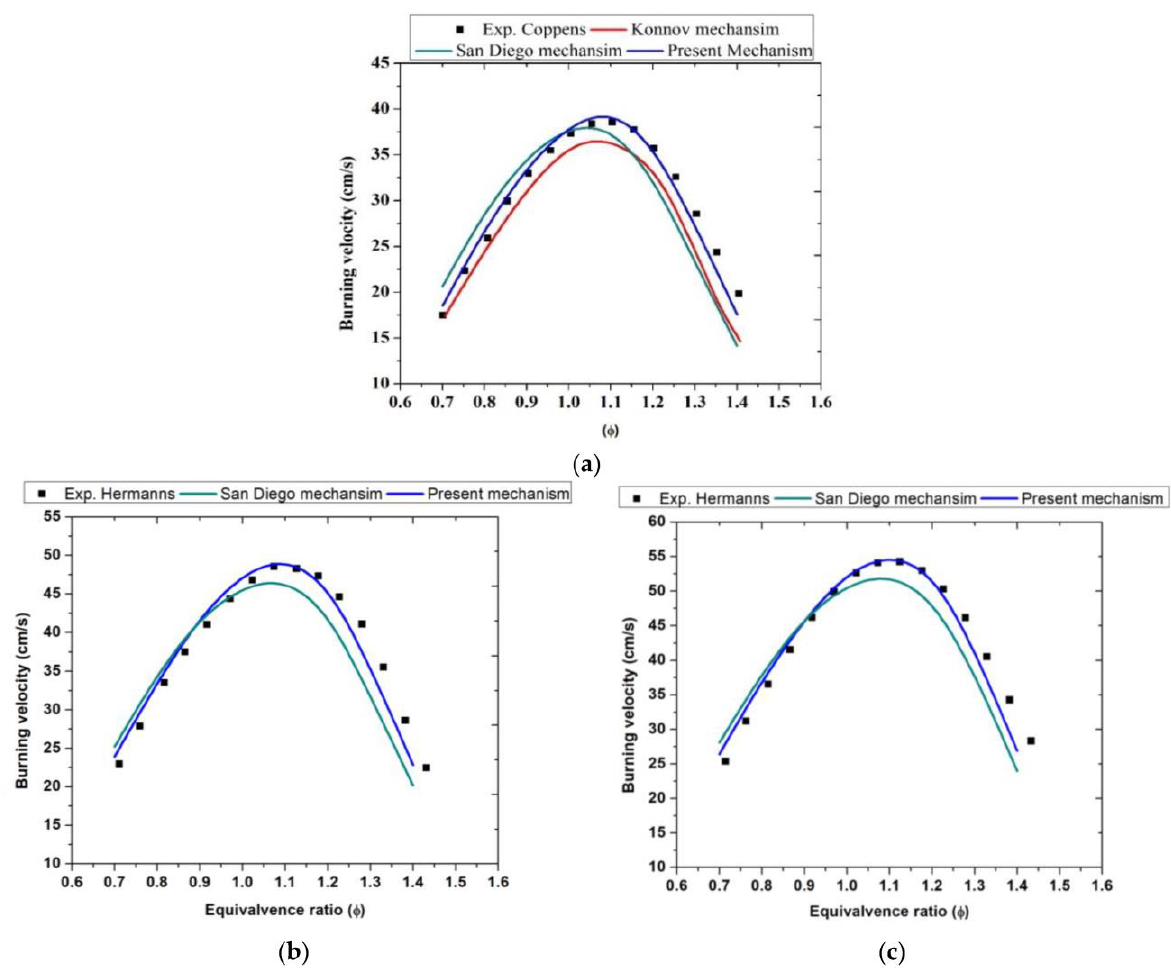
Figure 3. Validation: predicted values of burning velocities of CH 4 /H 2 /Air mixture with a H 2 content of ( a ) 5%, ( b ) 30% and ( c )